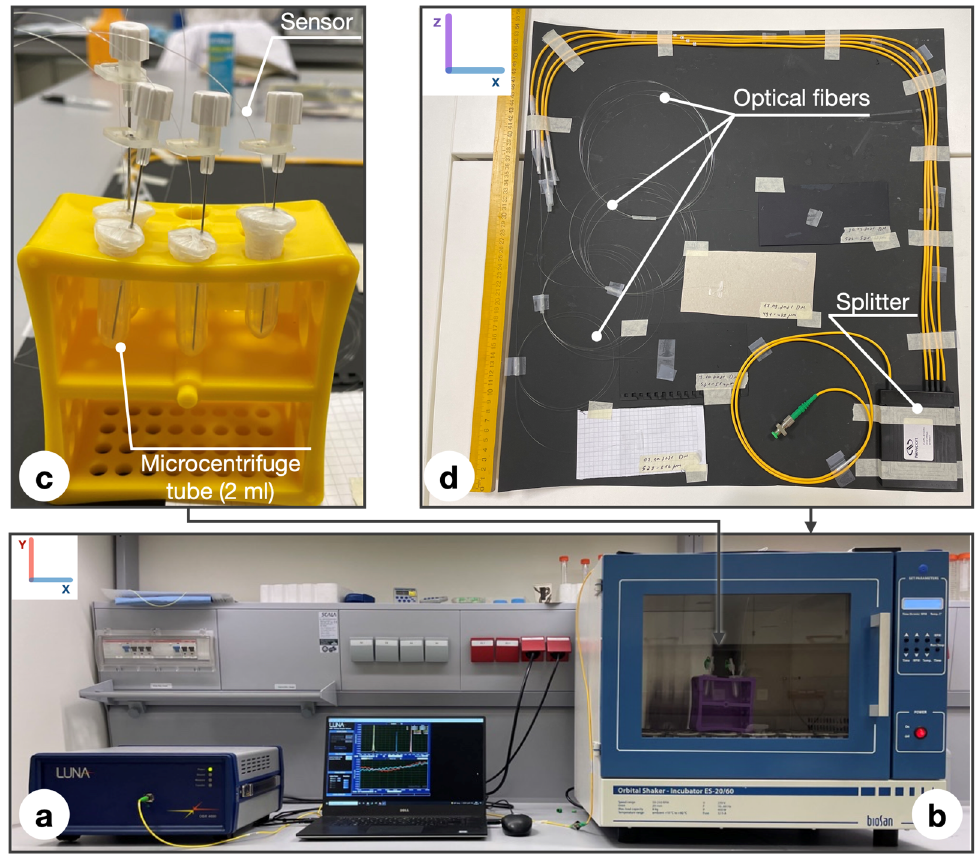
Figure 3. Set up of the experiment: ( a ) OBR Luna 4600 with a computer used for data acquisition; ( b ) incubator; ( c ) rack with probes consisting of microcentrifuge tubes (2 mL), parafilm wrapping, intravenous catheters (G18) containing ball resonator; ( d ) multiplexing set up consisting of splitter and optical